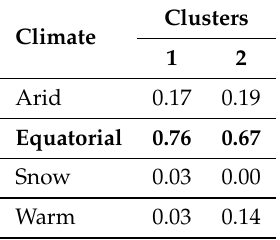
Table 10. Distribution of the categorical variable “climate”.